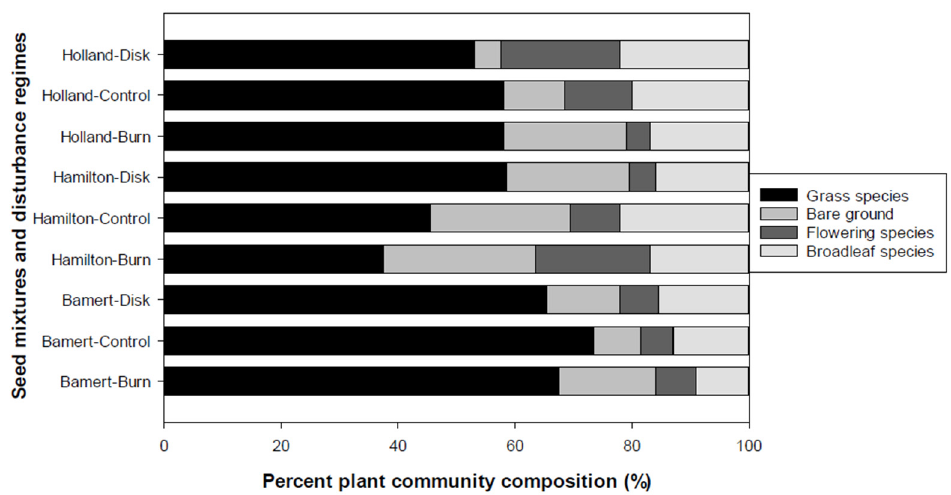
Figure 1. Plant community composition by pollinator mixture and disturbance regime averaged across years (2016–2017) at the Natural Resources Conservation Service Plant Materials Center in Booneville, AR. (Note that broadleaf species = broadleaf non-flowering weeds).